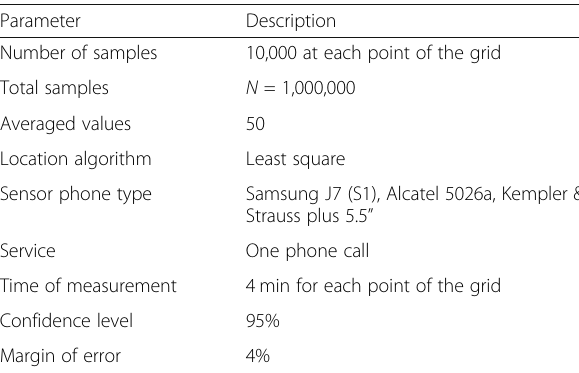
Table 4 Parameters for motion detection learning